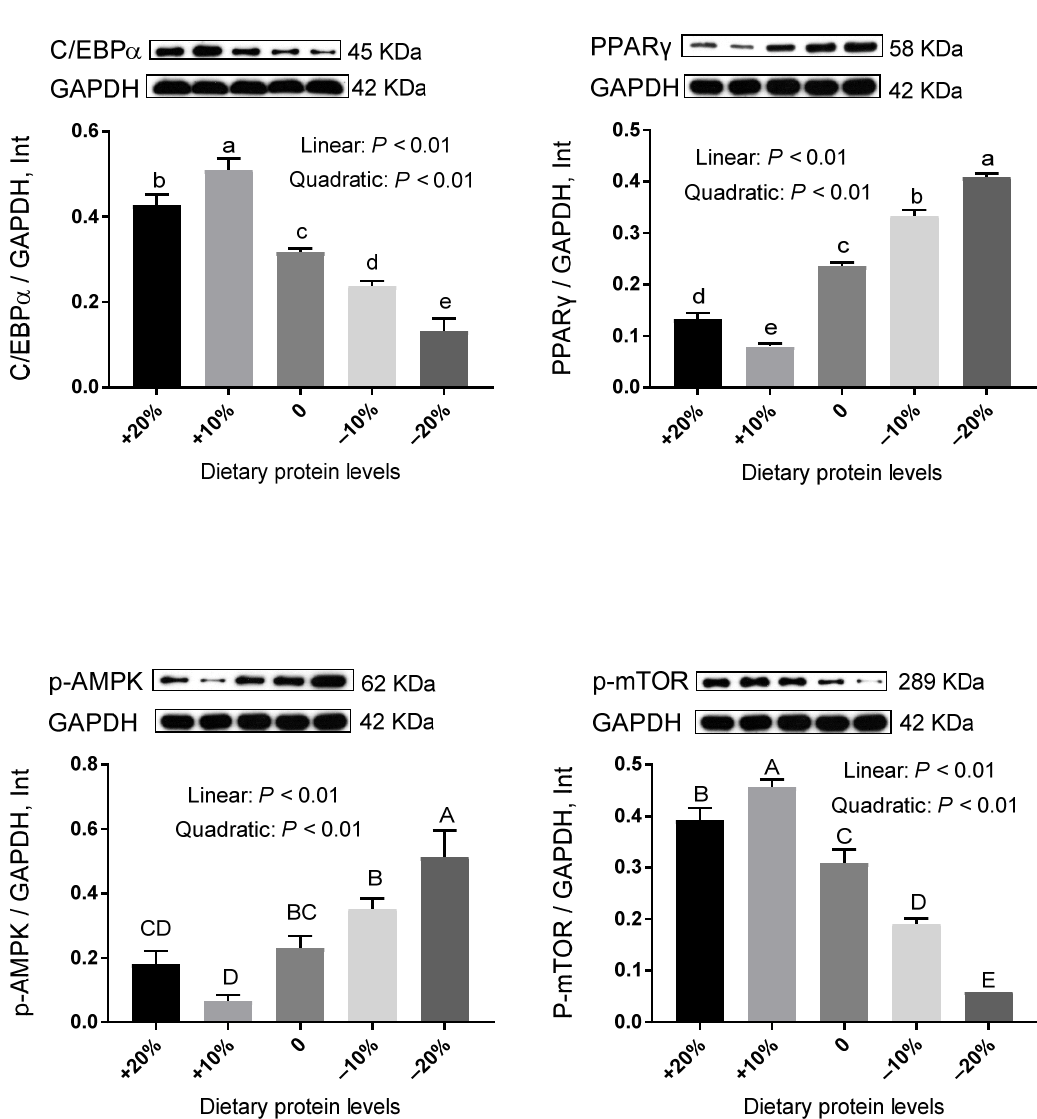
Figure 4. The relative protein expression level of genes related to lipid metabolism in the PRA of pigs fed different protein levels. Values are means, with their standard errors represented by vertical bars. a,b,c,d,e Values ( n = 3) within a row with different lowercase letters differ significantly ( p < 0.05) by the Kruskal–Wallis test. A,B,C,D,E Values ( n = 3) within a row with different capital superscripts differ significantly ( p < 0.05) by Duncan’s multiple comparisons.